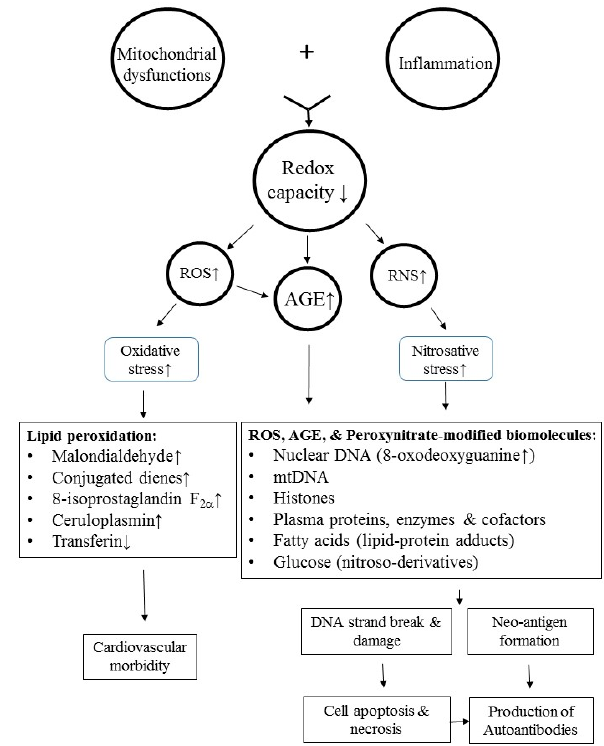
Figure 5. The molecular bases of mitochondrial dysfunction-elicited oxidative and nitrosative stresses in inducing autoantibody production and cardiovascular complications in patients with SLE. Redox: Reduction and oxidation; ROS: Reactive oxygen species; RNS: Reactive nitrogen species; AGE: Advanced glycation end-product; mt: Mitochondrial.